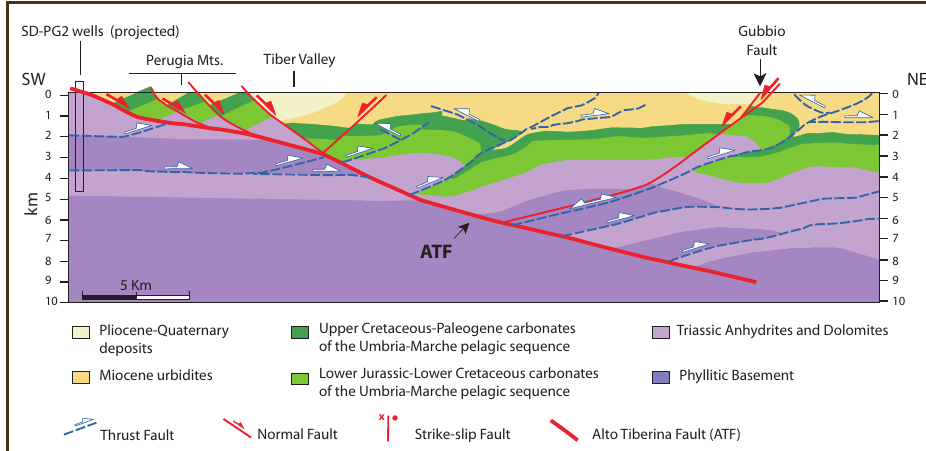
Figure 2. Geological cross-section through the Tiber Valley and the Gubbio anticline (modified after Collettini and Barchi, 2002). The section (see location A-A’ on Fig. 1) is based on the data set acquired during the CROP03 NVR project, including surface geology data, seismic reflection, and refraction pro- files, calibrated by deep boreholes (Anelli et al., 1994). SD and PG2: San Donato and Perugia 2 boreholes, respectively.